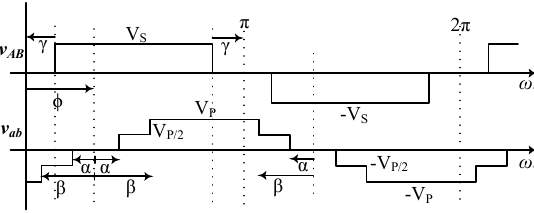
Figure 6. Voltage waveforms in a 3L-5L DAB boost topology when (cid:1874) using (cid:1830) < 0.5